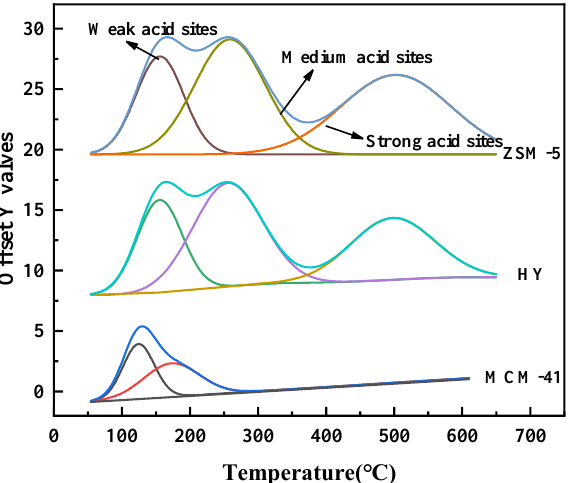
Figure 1. NH 3 adsorption/desorption isotherm distribution of samples. Table 2. Acidity distribution of three kinds of